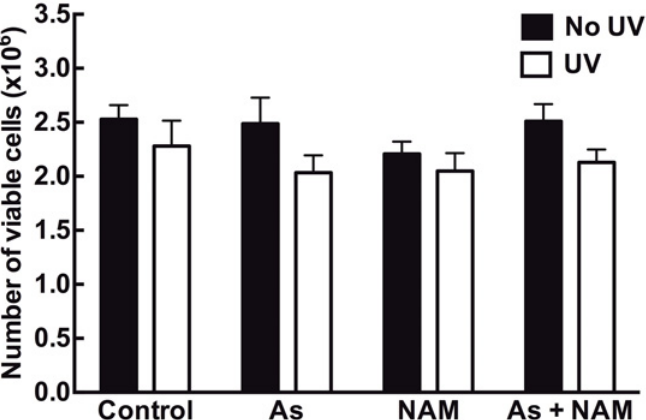
Fig 2. Viability of HaCaT keratinocytes is not affected by exposure to nicotinamide (NAM), sodium arsenite (As) and UV. HaCaT keratinocytes were exposed to 50 μ M nicotinamide, 2 μ M sodium arsenite or PBS (control) alone, with and without irradiation with 2 J/cm 2 of UV. Columns represent the mean of the experiments ± SEM (n = 6). There were no significant differences detected between the groups p > 0.05, one way